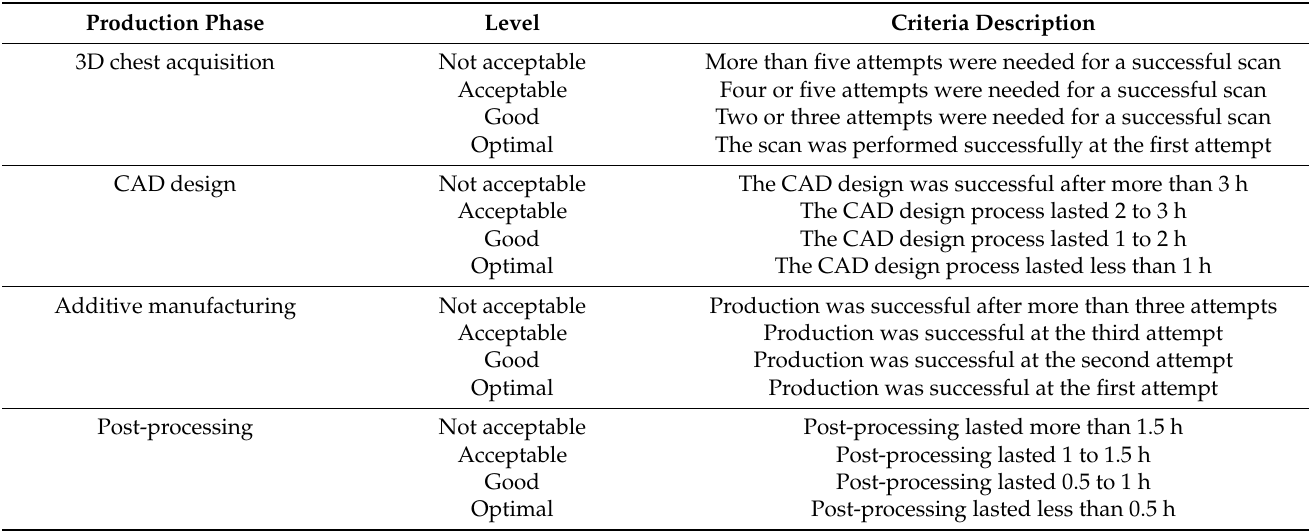
Table 2. Criteria for the evaluation of the four production phases of the 3D-printed braces.